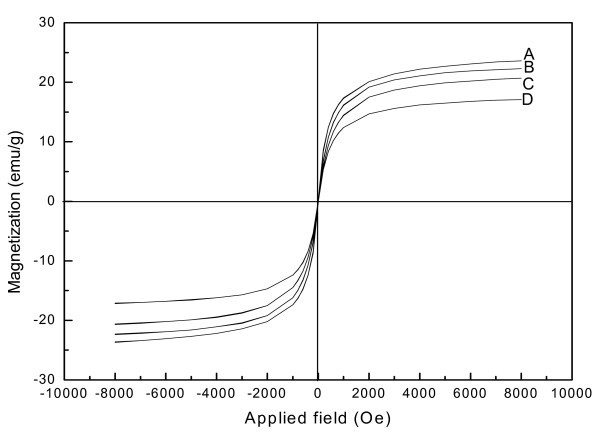
Magnetization curve of the Fe3O4@PPy prepared under different amounts of pyrrole monomer at 160°C: (A) 0 mL, (B) 0.1 mL, (C) 0.3 mL, (D) 0.5 mL.